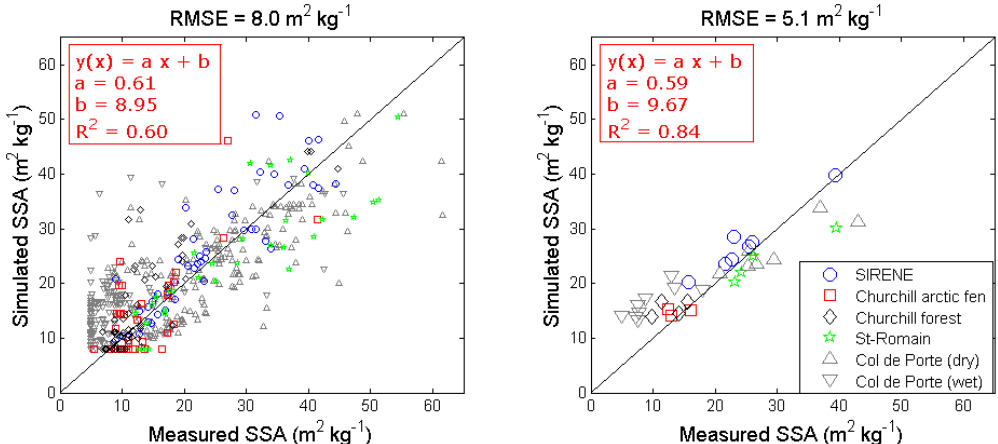
Fig. 7. Measured vs. simulated SSA comparison (left panel shows all points; right panel shows the one-layer average). The RMSE in averaged SSA (right panel) without the wet points is 4.1m 2 kg − 1 .